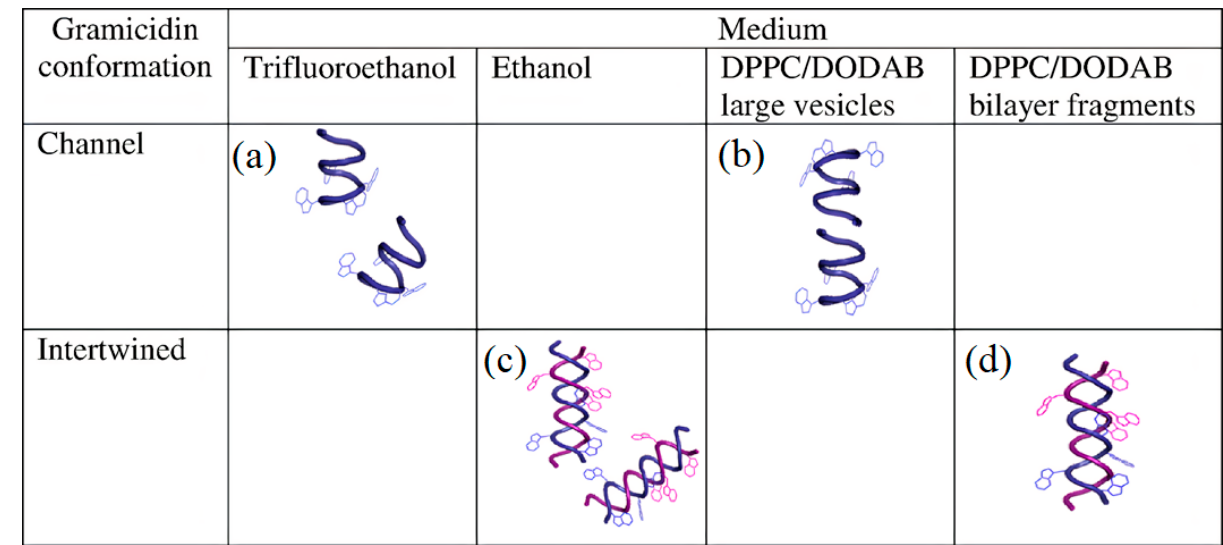
Figure 4. Medium − dependent gramicidin (Gr) conformation: ( a ) Gr beta − helix in trifluoroethanol, ( b ) Gr beta − helix and dimeric channel in large bilayer vesicles (LVs), ( c ) Gr intertwined beta − helices in ethanol, and ( d ) Gr intertwined beta − helices in lipid bilayer fragments (BFs). Gr molecules sense a nonpolar medium in the LV bilayer and acquire its functional channel conformation. Gr molecules sense a polar medium in the BF bilayer and become intertwined. The lipids in LVs or BFs are dipalmitoylphosphatidyl choline (DPPC) and dioctadecyl dimethyl ammonium bromide (DODAB) at a 1:1 molar ratio. Reprinted with permission from [64]. Copyright 2012 Elsevier.